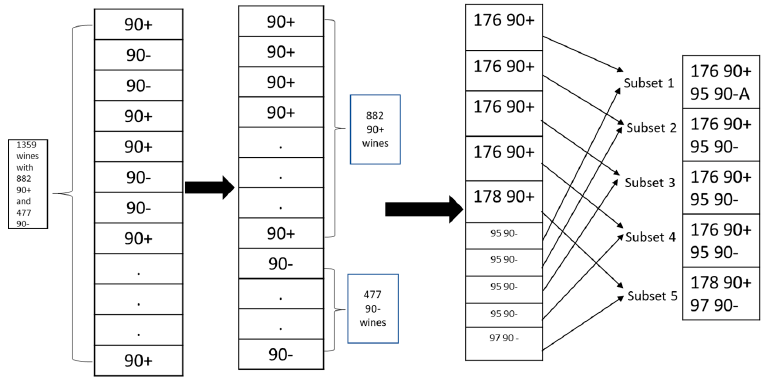
Figure 4. This figure demonstrates data splitting in 5-fold